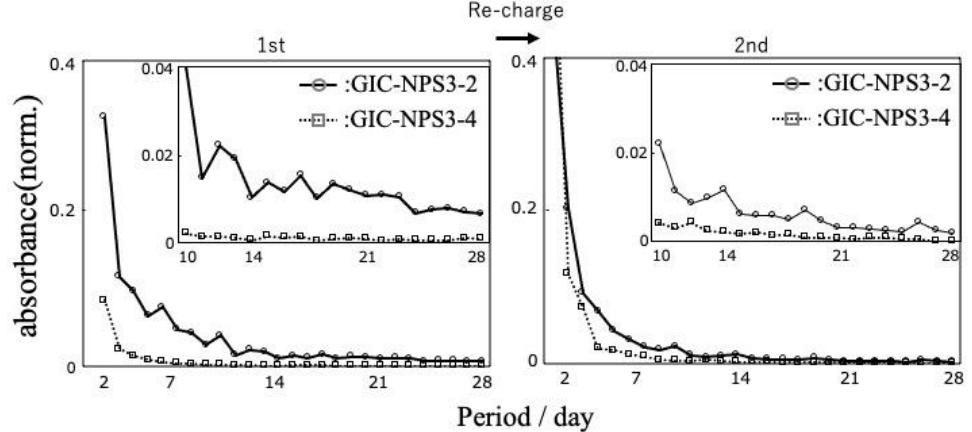
Figure 5. The time profile comparison of the absorbance of released RhB from GIC–NPS first charge and recharge.